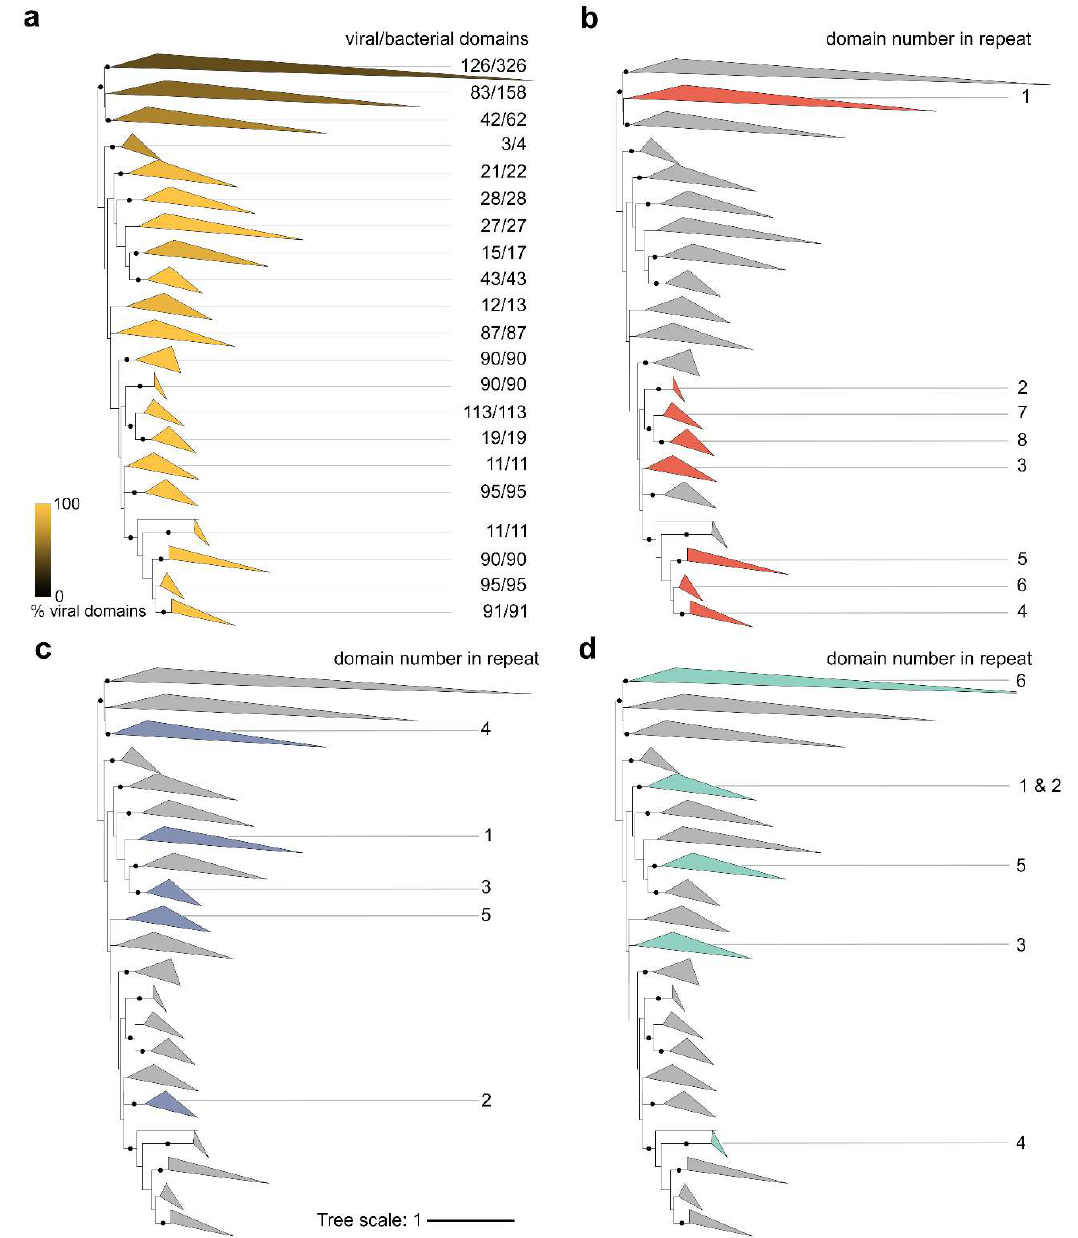
Figure 5. Domain phylogeny of crAss-BACONs in bacteria and phages reveals that the cluster 1 crAss-BACON tandem repeat resulted from multiple duplication events, whereas those in clusters 7 and B resulted from both horizontal transfer and duplications. Displayed is an unrooted approximate maximum likelihood tree [51] of 1205 crAss-BACONs and 304 BACON domains from Bacteroidetes species (those that were used to produce PF13004). Dots on branches denote bootstrap support > 90. The four versions of the tree depict the fraction of crAss-BACONs out of the total number of domains in each clade ( a ), and the locations of domains from the crAss-BACON tandem repeats in cluster 1 ( b ), 7 ( c ) and B ( d ). Shading and numbers in ( a ) denote the fraction of viral domains in each clade. Numbered clades in ( b – d ) represent the positions of domains in the crAss-BACON tandem repeat as counted from the N-terminus. For uncollapsed tree, see Figure S4, Supplementary Materials.